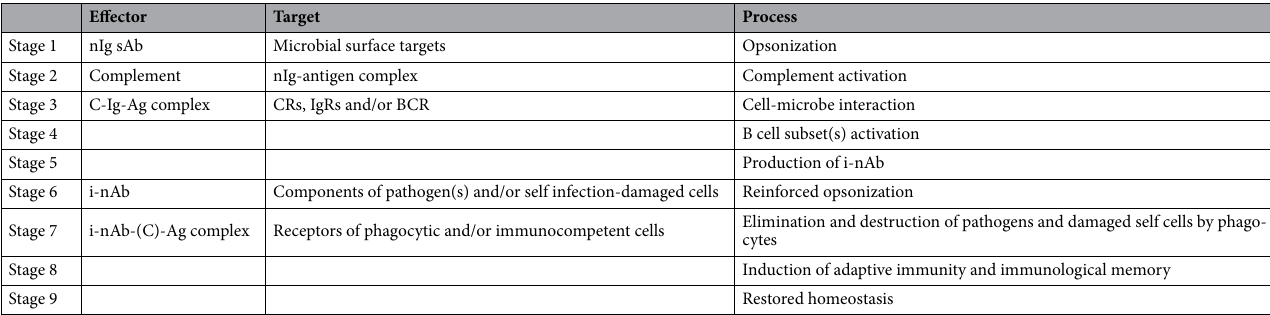
Table 1. Possible phases of infection-induced natural antibodies involvement in the restoration of homeostasis after infection. nIg sAb natural IgM soluble antibodies, IgRs immunoglobulin receptors, i-nAb infection induced early (natural) antibodies. The suggested scenario could be supported by the data from Francisella - host cell interaction demonstrating that IgM is essential for F. tularensis opsonization by complement